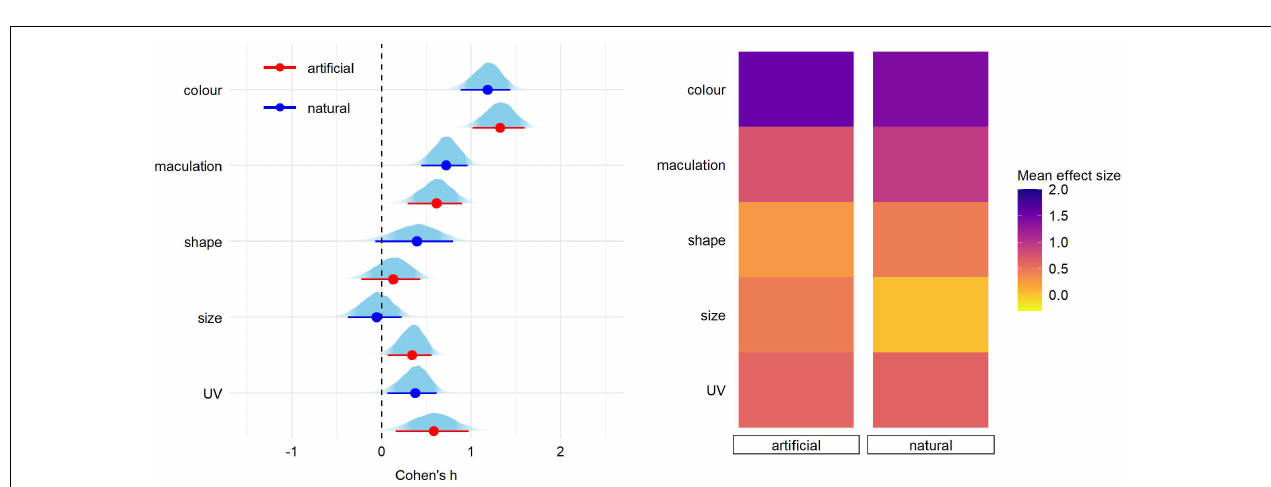
FIGURE 1 | Predicted overall effect size for egg trait types. On the left, for each trait type we show the parameter distribution with its median (black dot) and 89% credible interval (black line). On the right, the median effect sizes are plotted as a heatmap for each trait type.